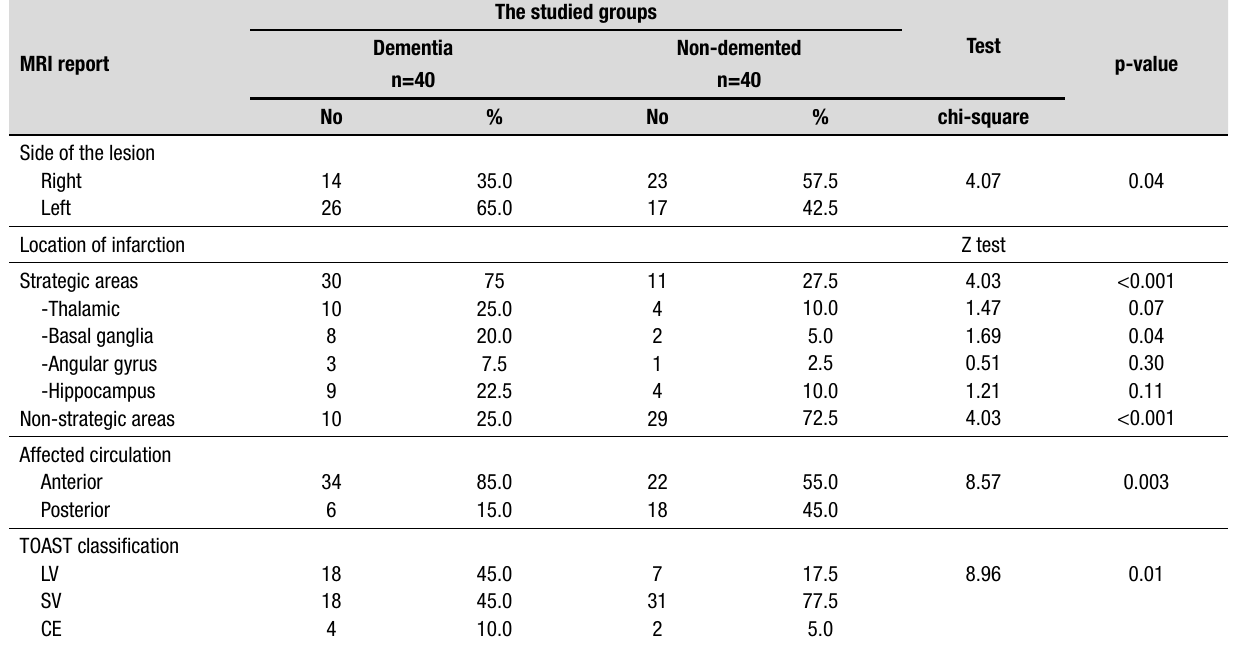
The studied groups